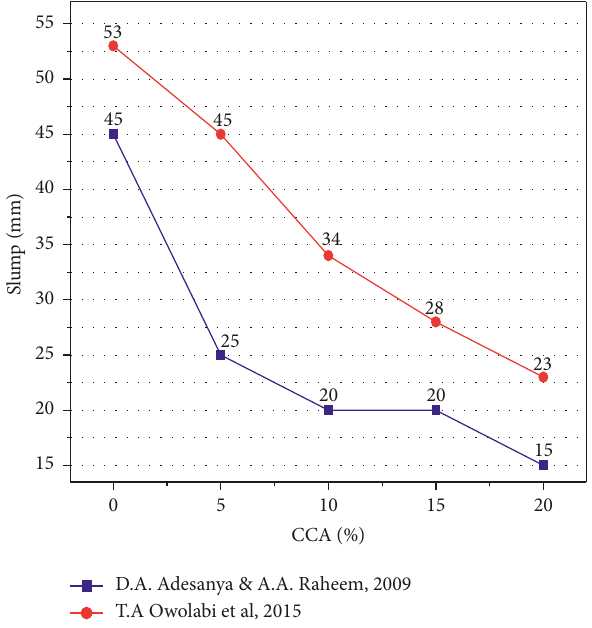
Figure 14: Slump test value for corncob leaves’ ashes blended